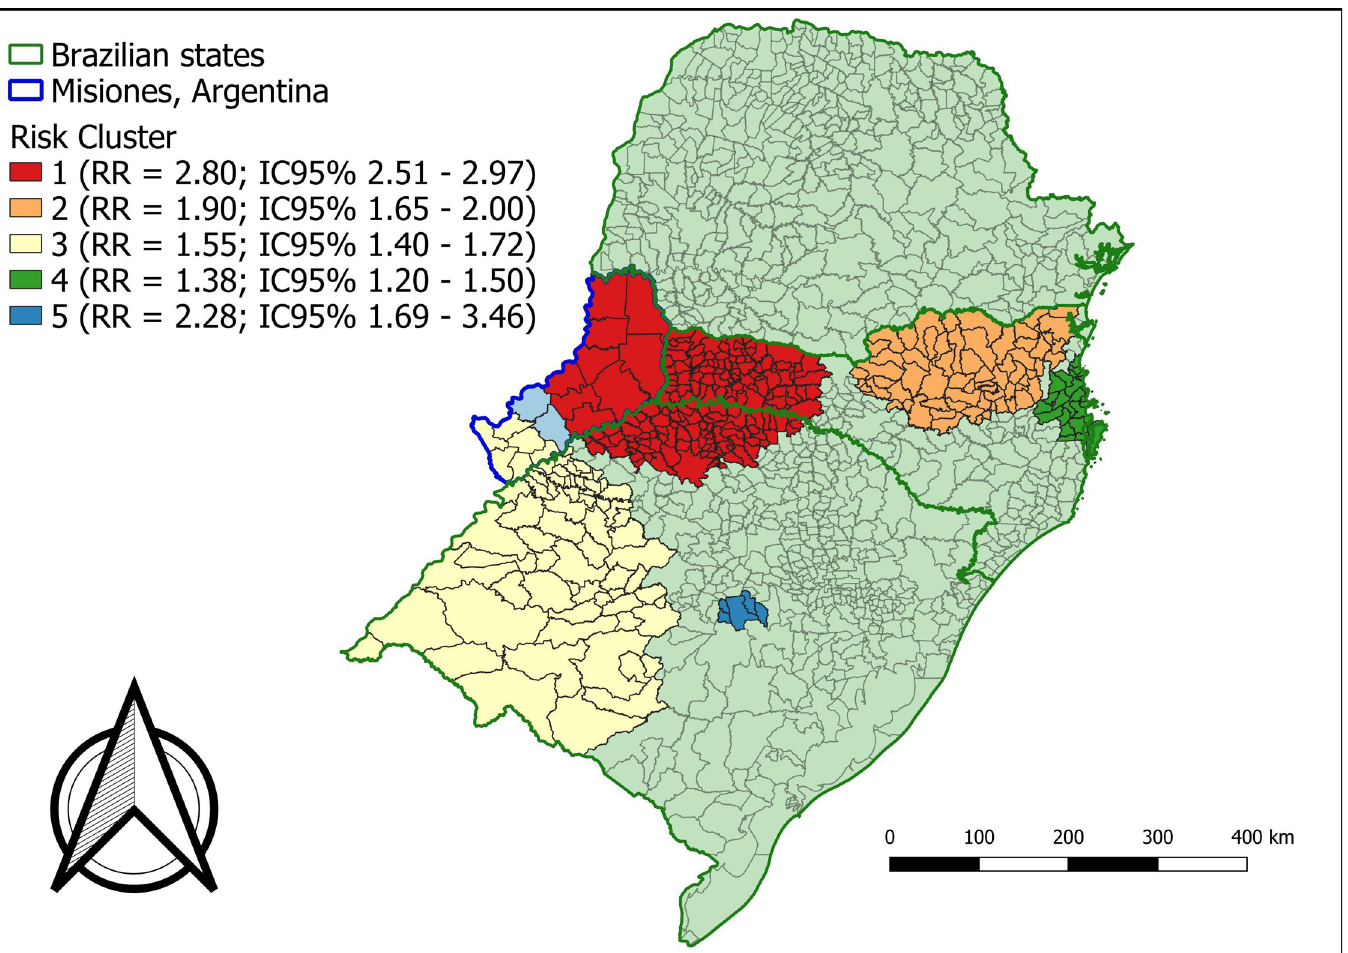
Fig 4. Areas of relative risk for new cases of leprosy in Southern Brazil (excluding Parana´) and Misiones, Argentina, 2010 to 2016.